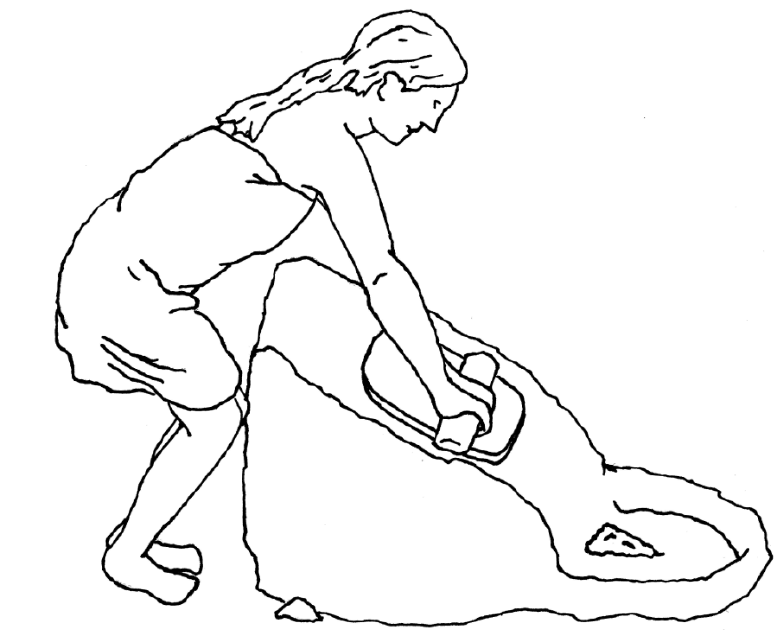
Figure 2: Woman grinding using a quern emplacement. Drawing courtesy of J.